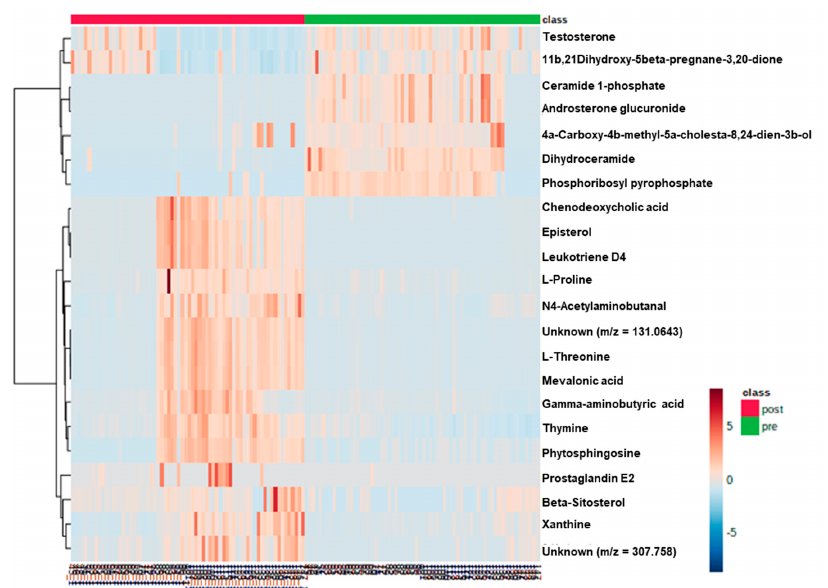
Figure 2. Heatmap of the 22 differentially accumulated metabolites. The heatmap provides a visualization of the changes in the abundance of metabolites specified in each row (normalized by log 10 scale). The color ranges from deep orange, indicating high abundance, to deep blue, indicating low abundance. On the top of the heatmap, green bars and red bars indicate pre-operative and post-operative patients with colorectal cancer, respectively.